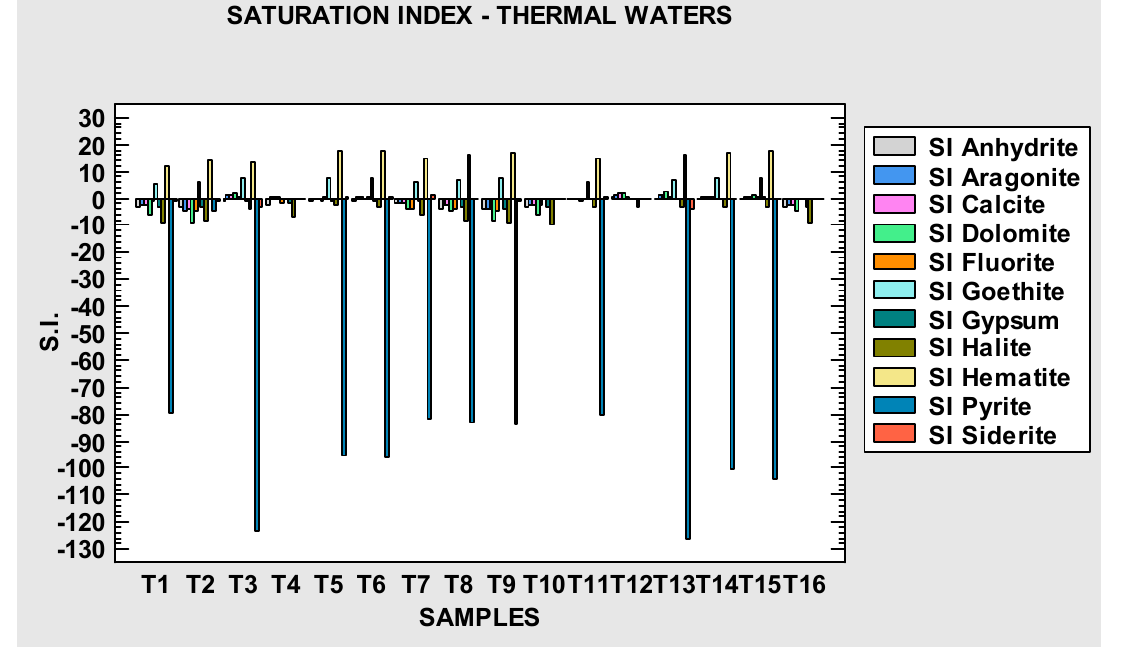
Figure 10. Saturation indices for geothermal water samples of the Paipa region.